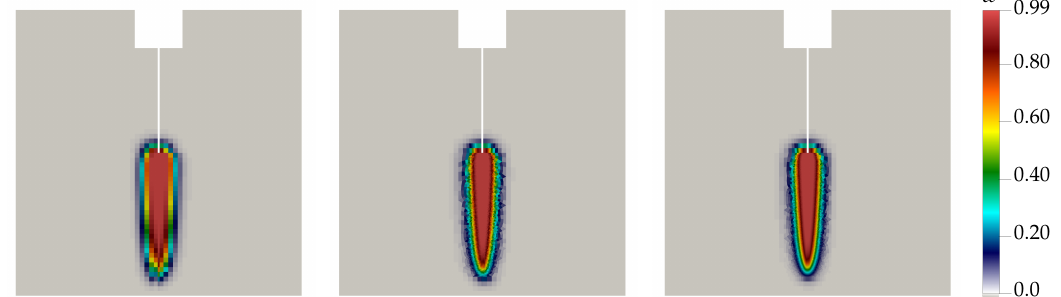
Figure 5. Distribution of the damage variable ω at CMOD = 0.3mm for the three structured finite element meshes: coarse ( left ), medium ( center ), and fine ( right